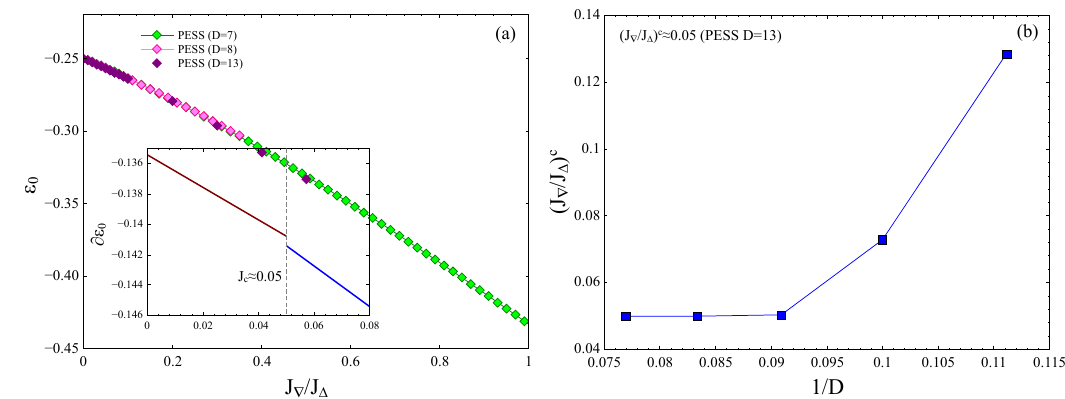
Figure 8: (Color online) (a) Ground-state energy per-site of the BKH model for 0 ≤ J (cid:53) / J (cid:52) ≤ 1. The U(1) QSL persists to large breathing anisotropies and breaks down to a lattice-nematic phase at J (cid:53) / J (cid:52) ≈ 0.05. The inset shows the derivative of = c + 2 c ( J / J ) , obtained with c the energy series, ∂ (cid:34) and c coefficients of the (cid:53) (cid:52) 0 1 2 1 2 nematic and U(1) QSL phases from Table 2 for D = 13. The sharp discontinuity in the derivative is a clear signature of the first-order phase transition. (b) Scaling of the location of the transition point with inverse bond dimension, 1 / D